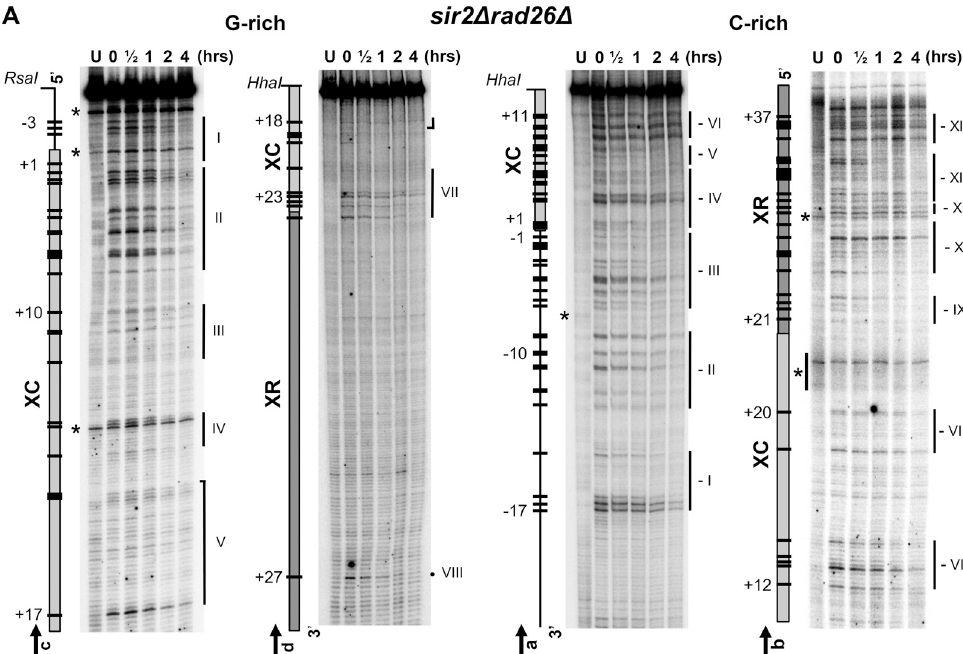
Fig 8. Mapping of pyrimidine dimers in the Tel15L X-element of sir2 Δ rad26 Δ cells at nucleotide resolution. The DNA was prepared and assessed for the presence of PDs as described in Figs 3 and 4 . Description of maps on the left of sequencing gels is as in the previous figure legends. PDs that were quantified and plotted in S13–S16 Figs are represented by black bars and numbered negatively or positively when present outside or inside of the X-element, respectively. The position of PDs was verified by DNA sequencing lanes (not included in the figure). Symbols are as described in the previous figure legends, and vertical bars mark PD clusters (‘I’ to ‘VIII’ and ‘-I’ to ‘-XII’).